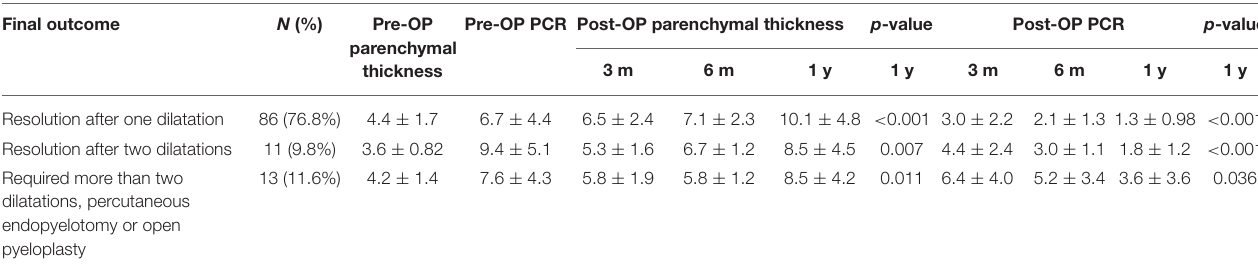
TABLE 5 | Follow-up ultrasounds: parenchymal thickness and pelvis/cortex ratio.